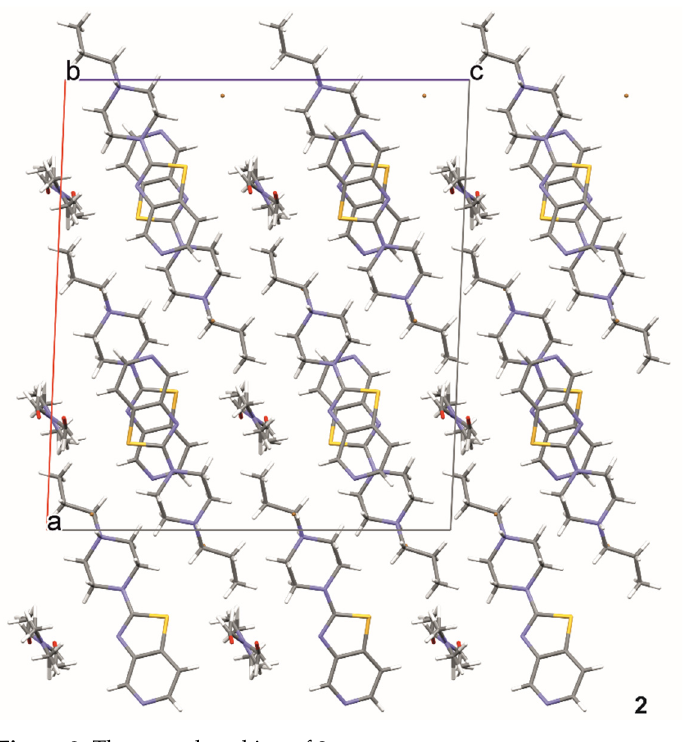
Figure 9. The crystal packing of 2 . Table 3. Strong hydrogen-bond geometry (Å, º) for 2 .